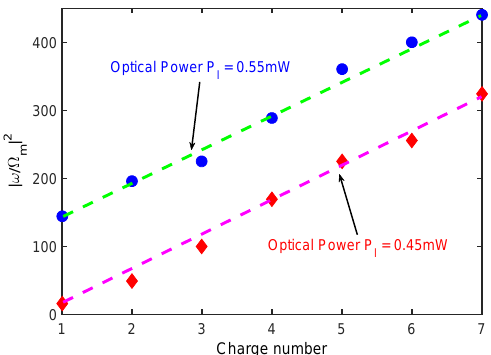
Figure 5. The relationship between the charge number n and the square value of the sidebands cutoff order | ω / Ω m | 2 in the presence of two-level atoms under different optical power. The other parameters are the same as those in Figure 2.